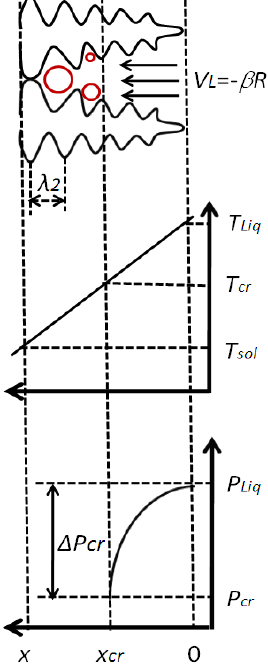
Figure 1. The schematic of mushy zone solidifying. Reproduced from